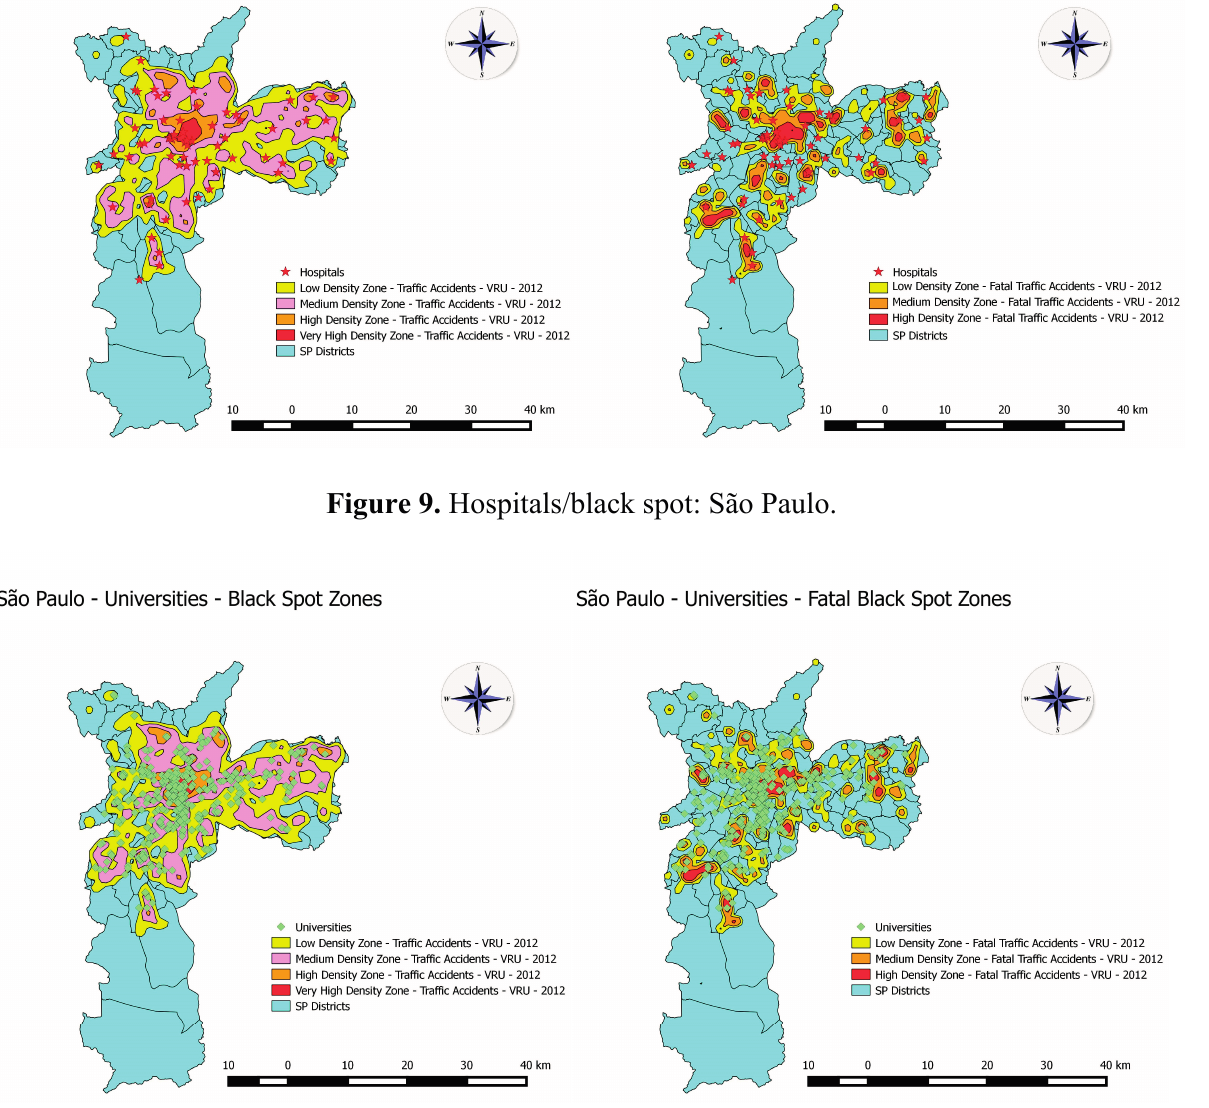
Figure 10. Universities /black spots: São